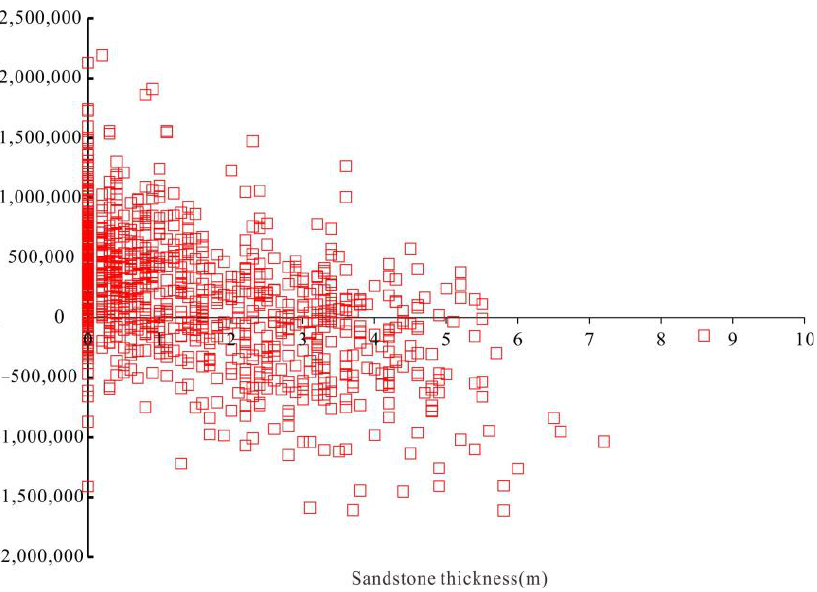
Figure 4. Cross-plot of the amplitude and sandstone thickness of layer G I 2 .